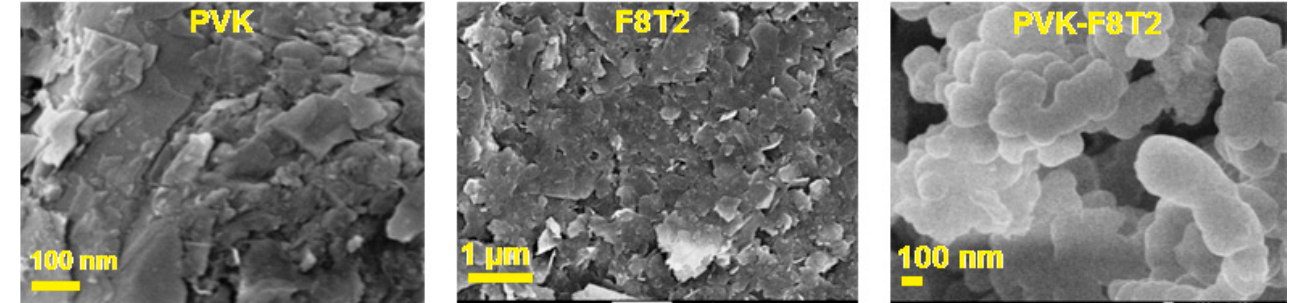
Figure 5. SEM Images of PVK, F8T2 and PVK-F8T2.